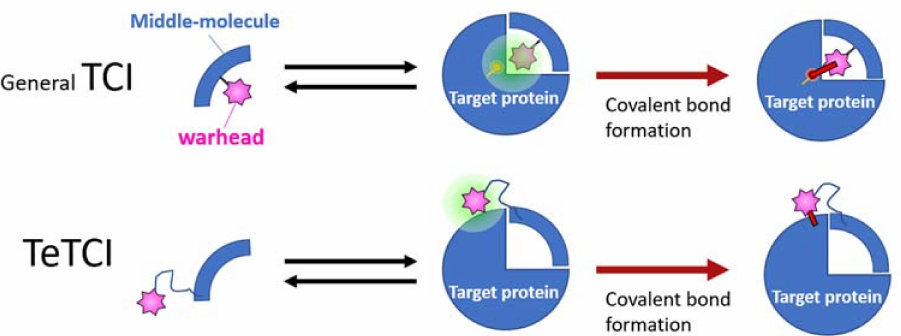
Figure 7. A graphical summary of the conventional vs. tethered TCI (abbreviated as TeTCI). The general TCI (top row, blue quarter) endowed with a warhead (pink star) follows a two-step binding to form a covalent bond with the amino acid (s) usually within the TCI docking domain of the target protein (right). A TeTCI (second row) where the warhead attaches to the drug modality (e.g., a nucleotidic aptamer) through a long linker similarly binds to the target, but the site of covalent attachment is outside the docking domain. This distinction between the drug docking site and the site of covalent bond formation (i.e., general vs. TeTCI) is not modality dependent since some small molecule TCI endowed with a warhead with a long linker also reacts with residues outside of the presumptive docking